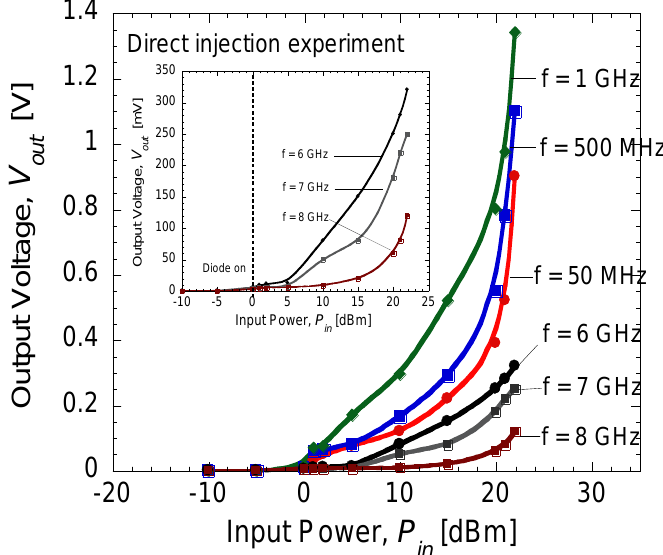
Figure 4. Rectified output voltages as a function of input voltages at different frequency